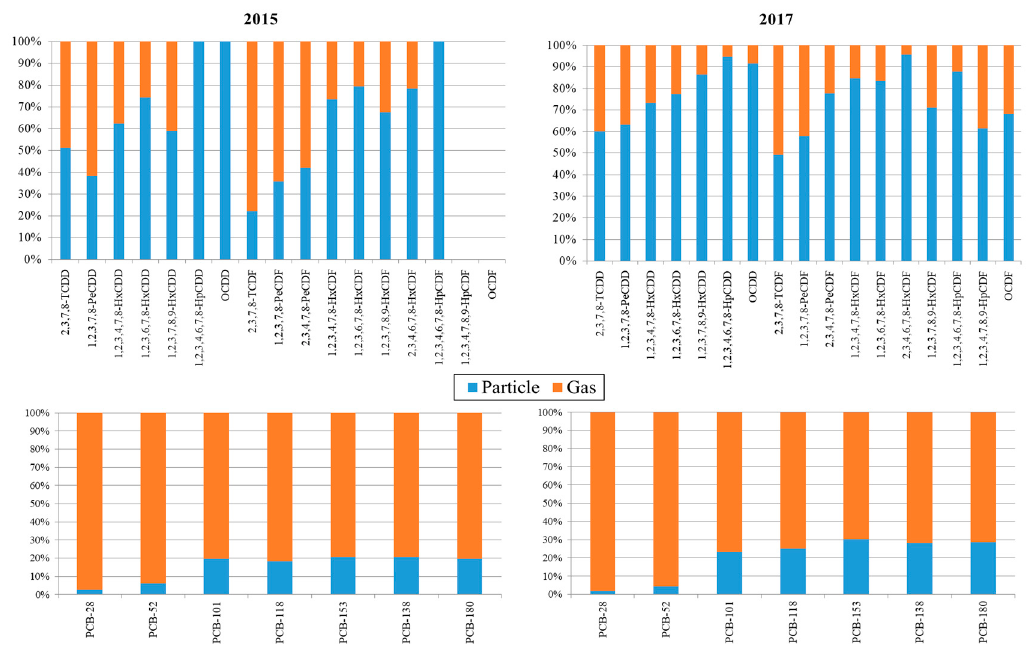
Figure 4. Congener profile of PCDD/Fs and PCBs in samples of air collected near the MSWI of Mataró in 2015 and 2017 according to the gas:particle distribution (ND: Not detected).